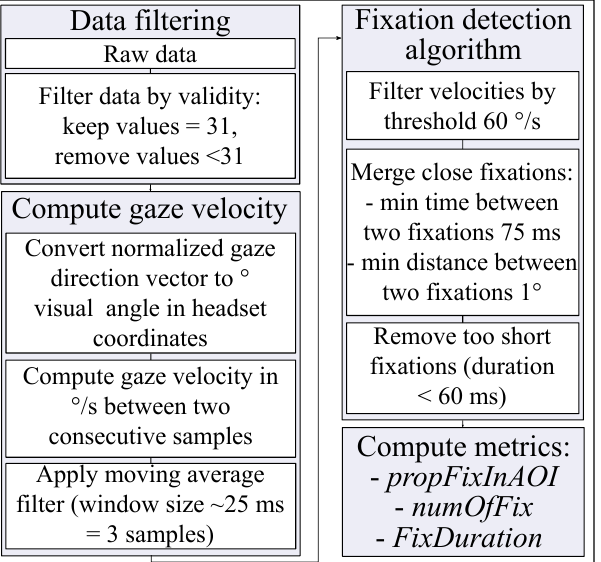
Figure 7. Eye movement data processing algorithm. For details see Section